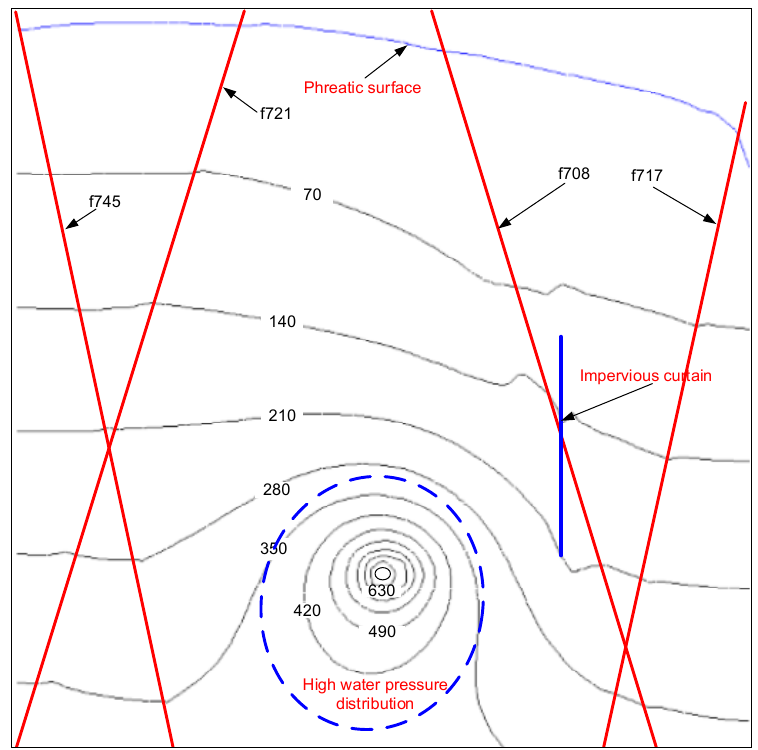
Figure 7. Phreatic surfaces and pressure distribution in the surrounding rocks at cross-section I-I.